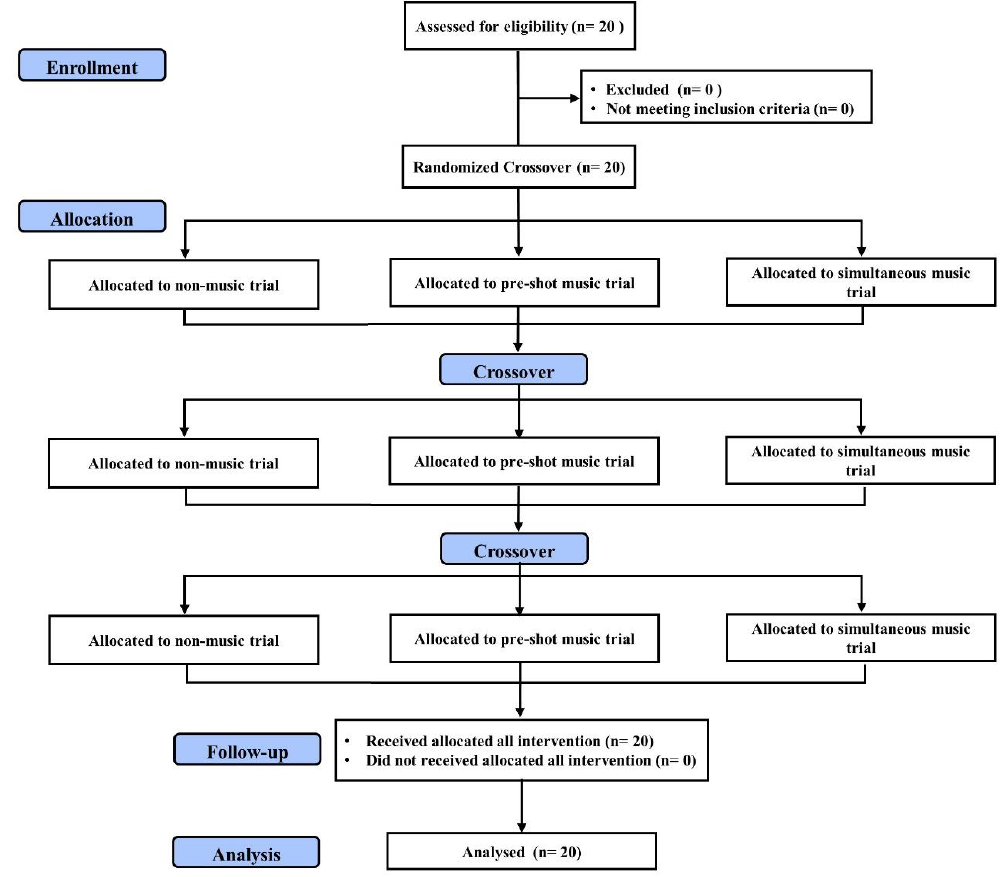
Figure 1. Flow diagram of the study.